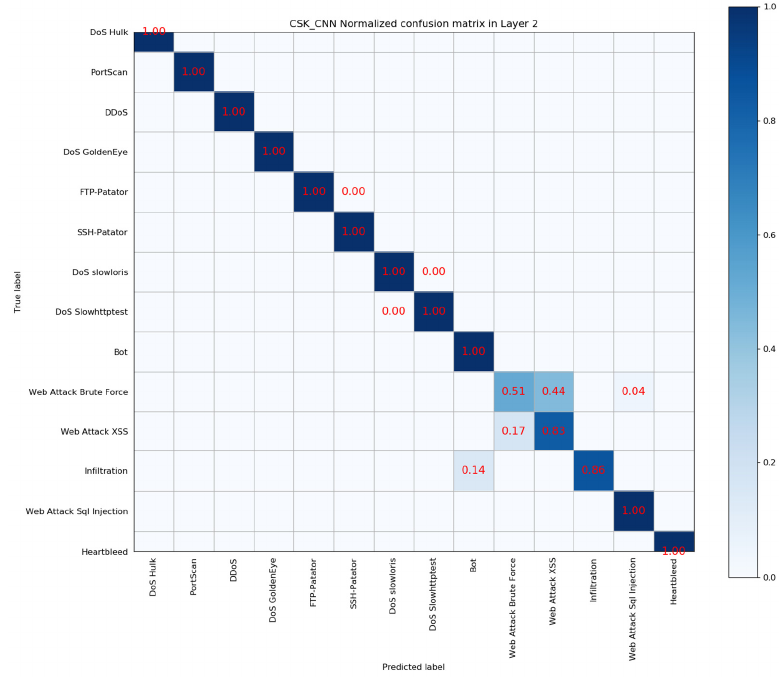
Figure A2. Layer 2 confusion matrix for CICIDS2017 Dataset.